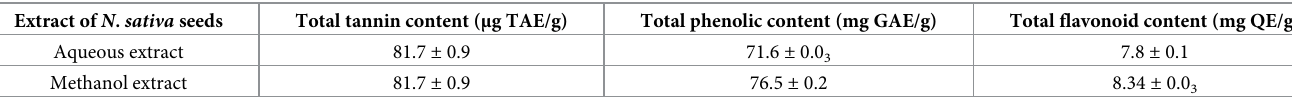
Table 2. Content of phytochemicals in the extracts of N . sativa seeds (mean ± SD; n = 3). Extract of N . sativa